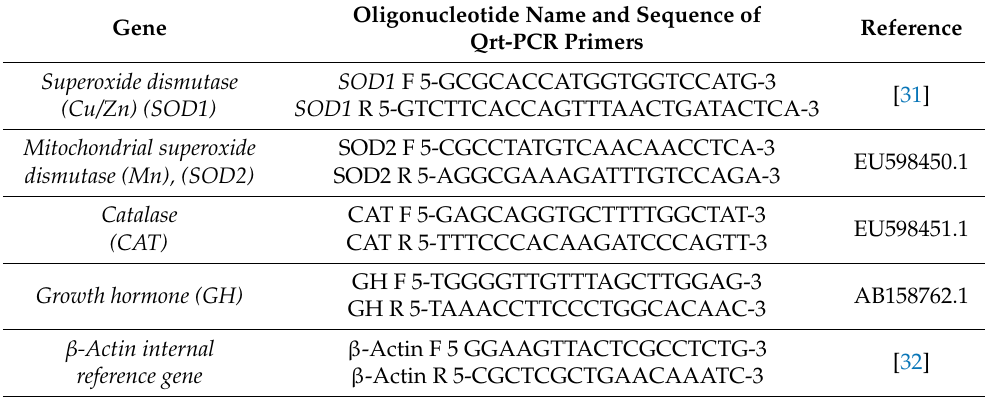
Table 4. Oligonucleotide name and sequence of qRT-PCR